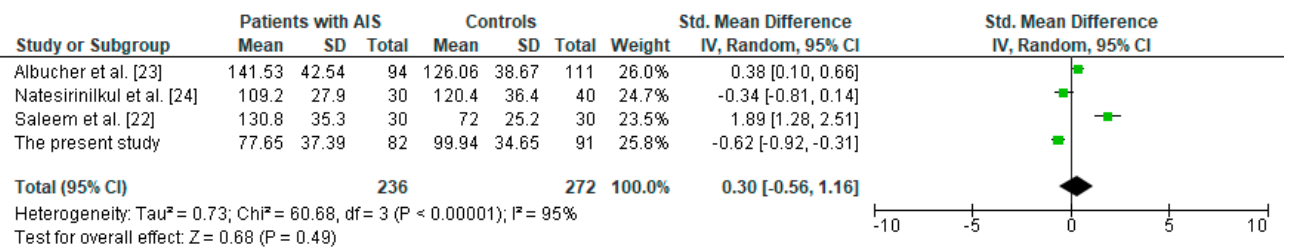
Figure 4. Forest plot for TC level in the groups of pediatric patients with AIS and controls [22–24]. TC—total cholesterol; AIS—arterial ischemic stroke; CI—confidence interval; I 2 —heterogeneity; df—degrees of freedom.